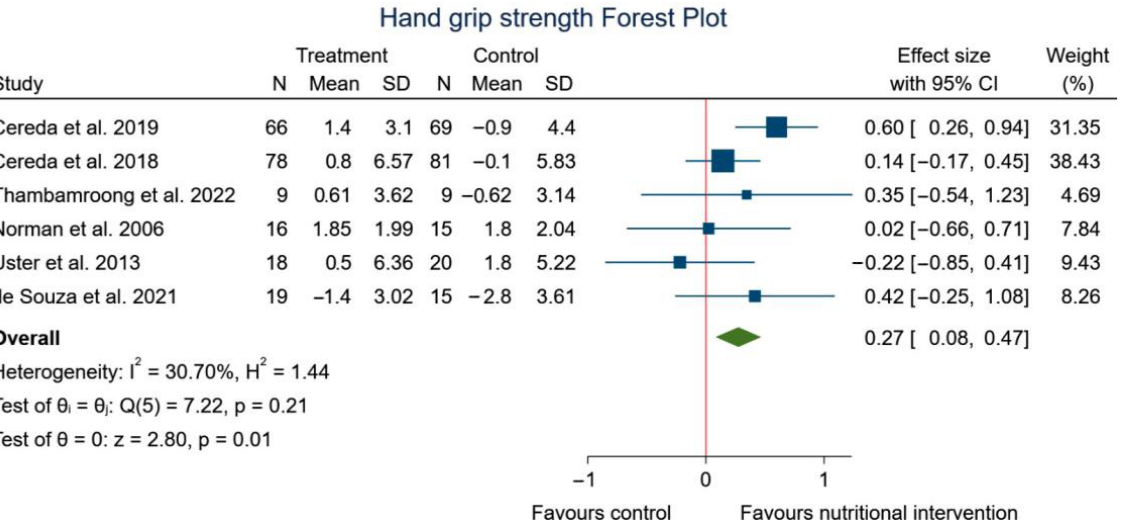
Figure 6. Forest plot summarizing the impact of nutritional intervention on weight using a fixed- effects model. Pooled summary data are presented as standardized mean differences and 95% confidence interval [39–42,52,54,55].